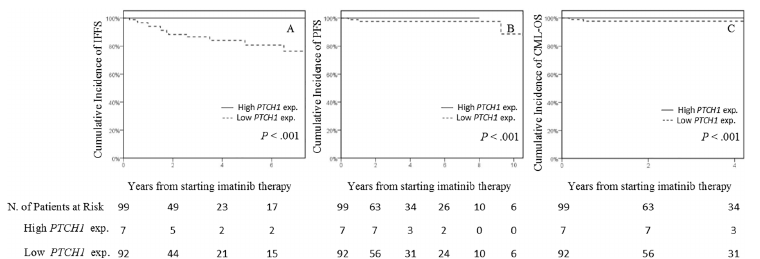
Fig 4. Cumulative incidence analysis of three different outcomes among high and low PTCH1 expression groups established using previously published thresholds. HR, hazard ratio; exp, expression; IFFS, imatinibfailure-freesurvival; MMR, major molecularresponse; PFS, progression-free survival; CML-OS, CML-related overall survival; N, number. The solid line indicateshigh PTCH1 expression and the dashed line low PTCH1 expression. Non-CML-relateddeath was considered a competingrisk in every variableanalyzedby the cumulative incidenceprocedure.In addition,discontinuation of imatinib due to side effects was considereda competing risk for the analysisof IFFS. The HR is not shown if no event was recordedin any of the groups due to non-preciseestimations. (A) IFFS analyzedby the cumulative incidence procedure and the Fine-Gray test. (B) PFS analyzedby the cumulativeincidenceprocedureand the Fine- Gray test. (C) CML-OS analyzedby the cumulative incidenceprocedure and the Fine-Gray test.